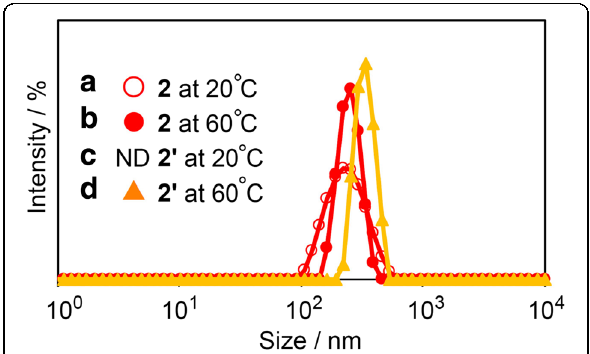
Fig. 4 DLS data of 0.2 wt% aqueous solutions of 2 and UV irradiated 2 for 15-min assemblies at different temperatures. 2 at 20 °C ( a ) and at 60 °C ( b ). UV irradiated 2 ’ at 20 °C ( c ) and 60 °C( d )